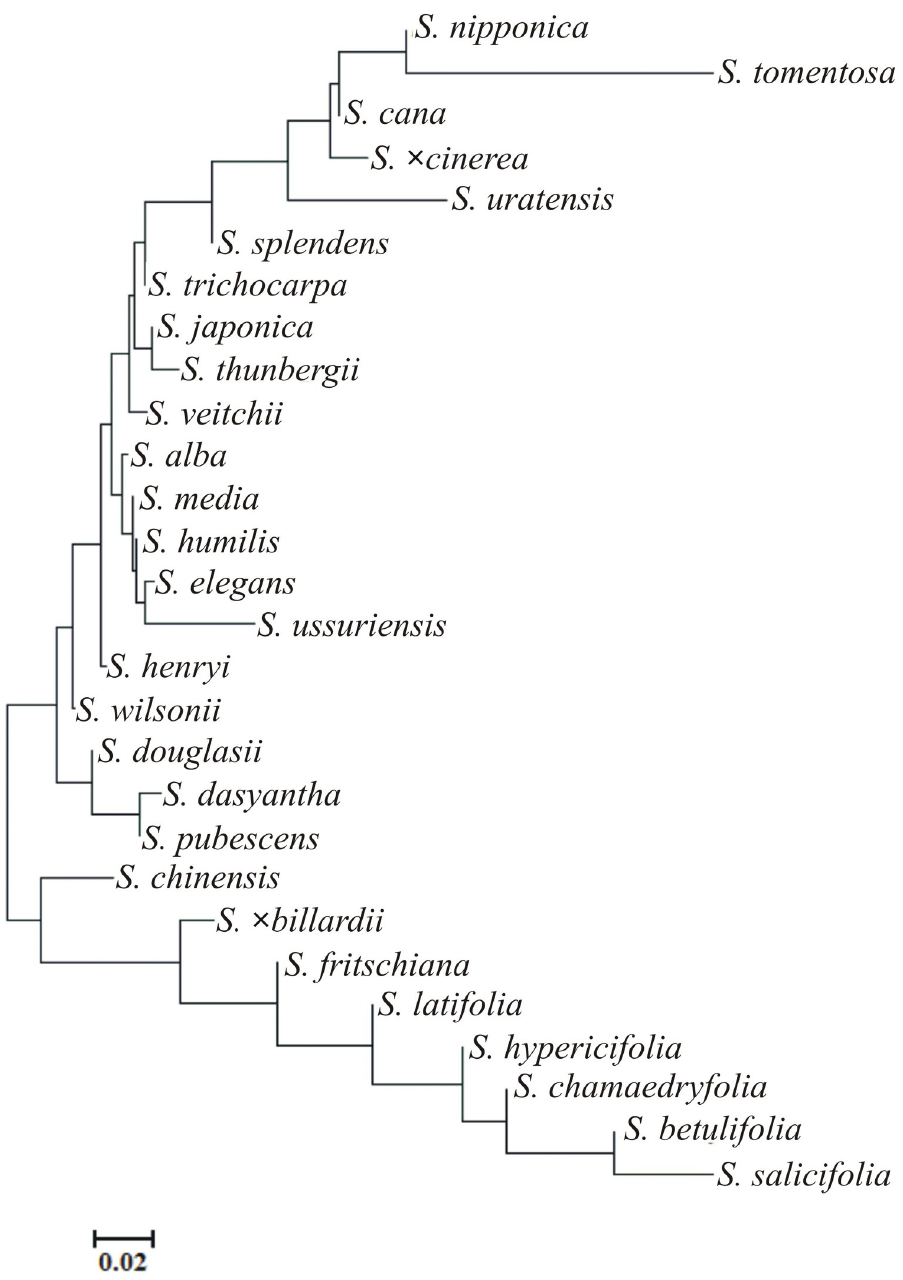
Fig 12. The phylogenetic tree of distribution of pollen morphological